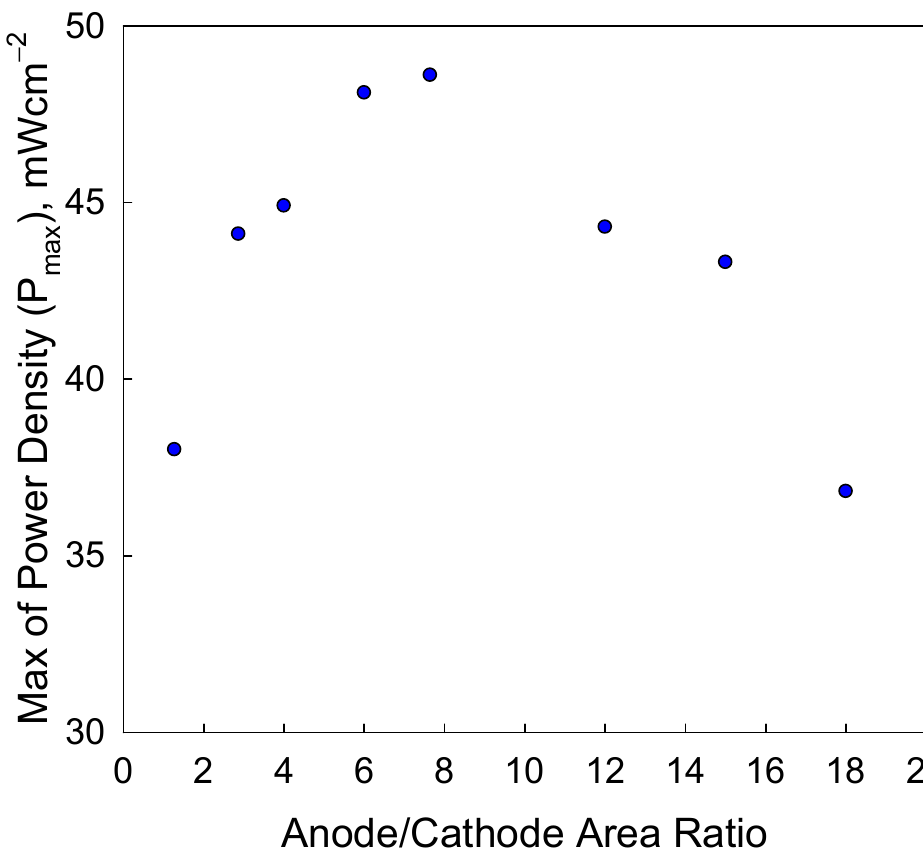
Figure 8. Plot of Pmax against area ratio of zinc electrode to air electrode in case of Cell 3.